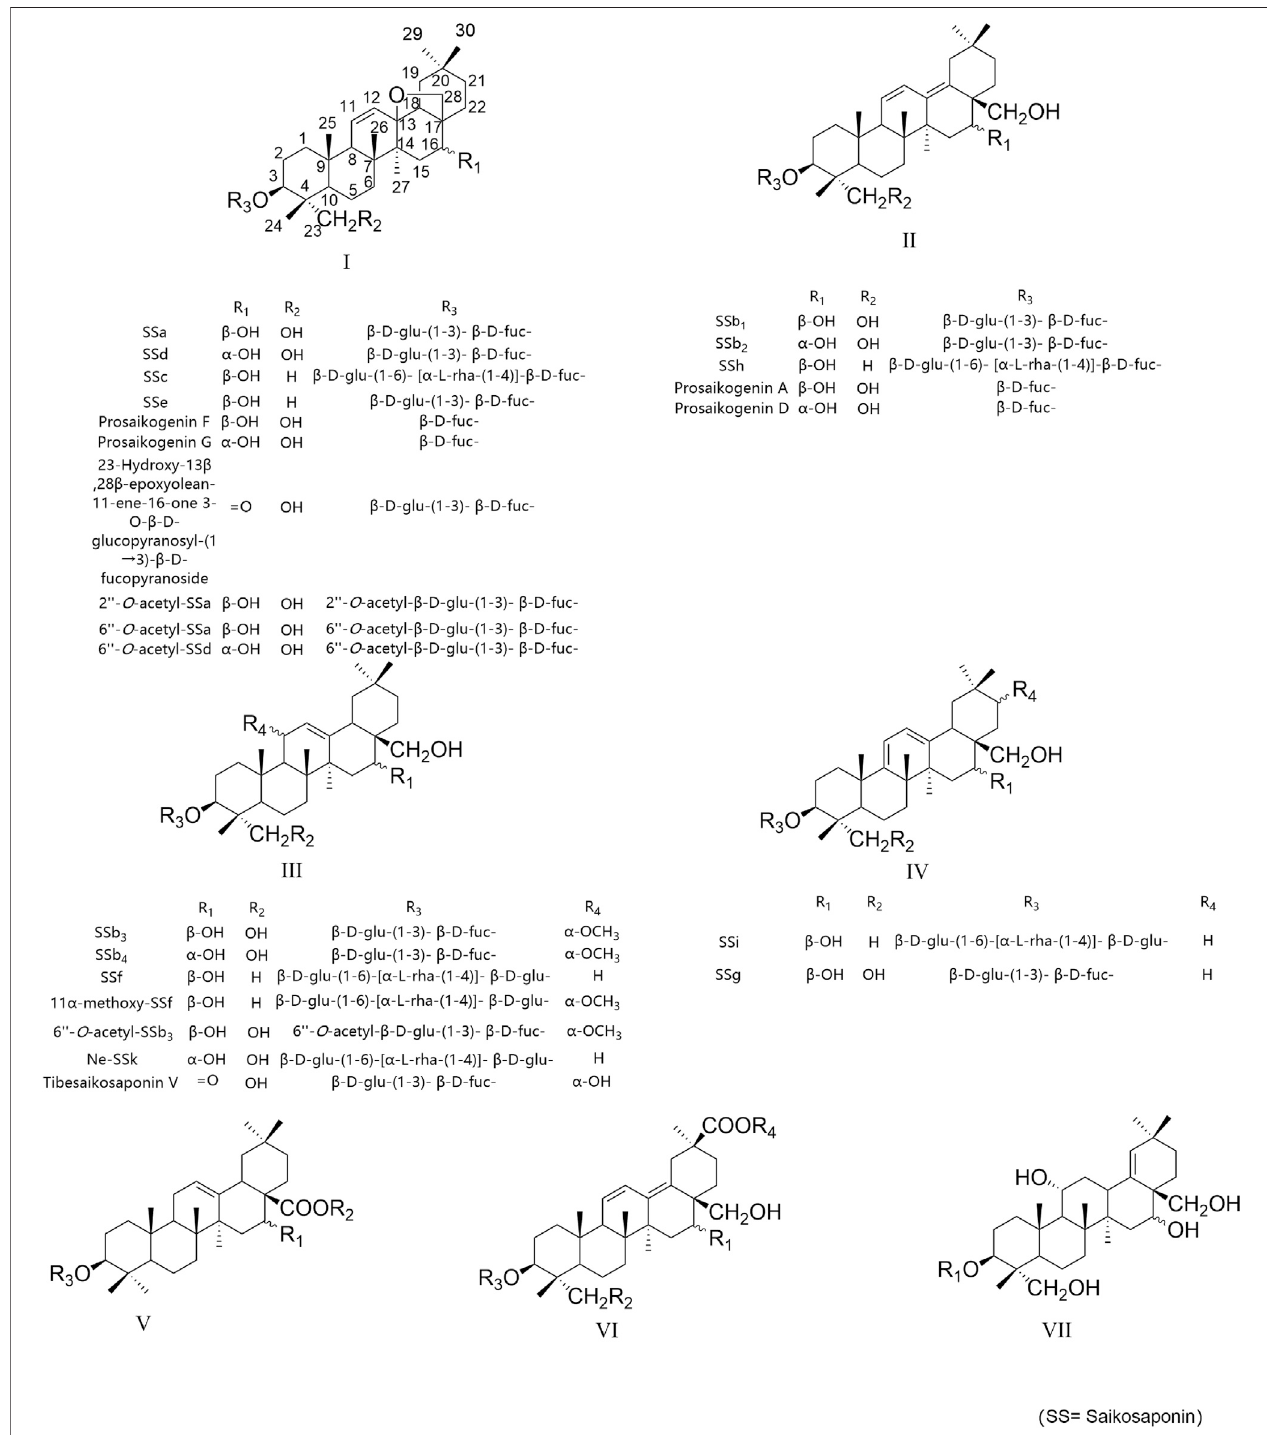
FIGURE 1 | Structures of major